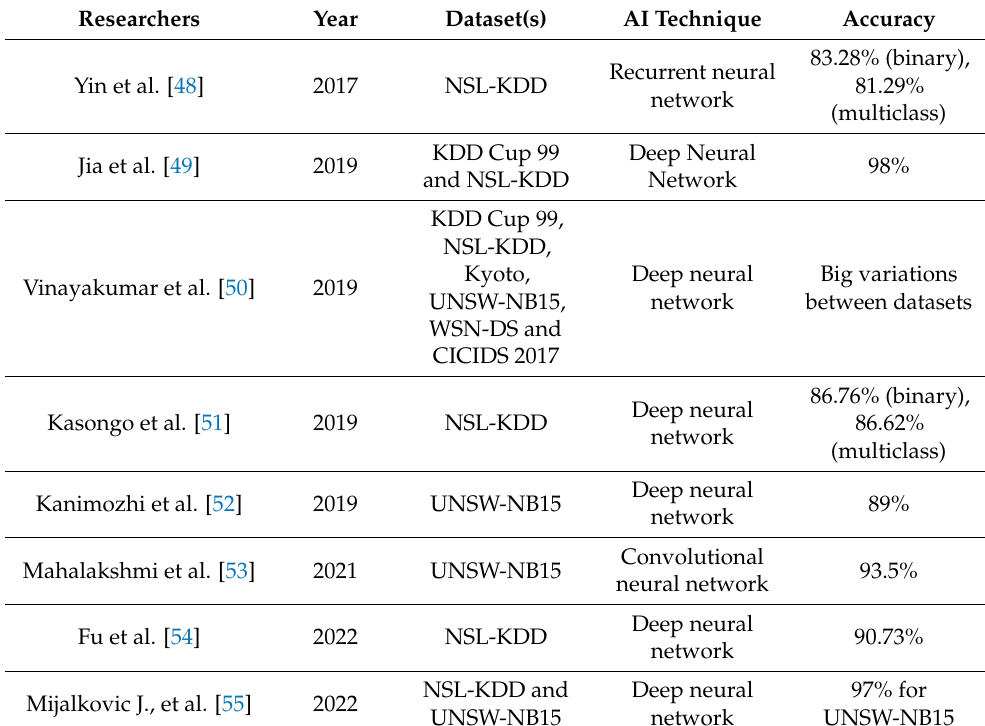
Table 1. A comparison of algorithms accuracy for